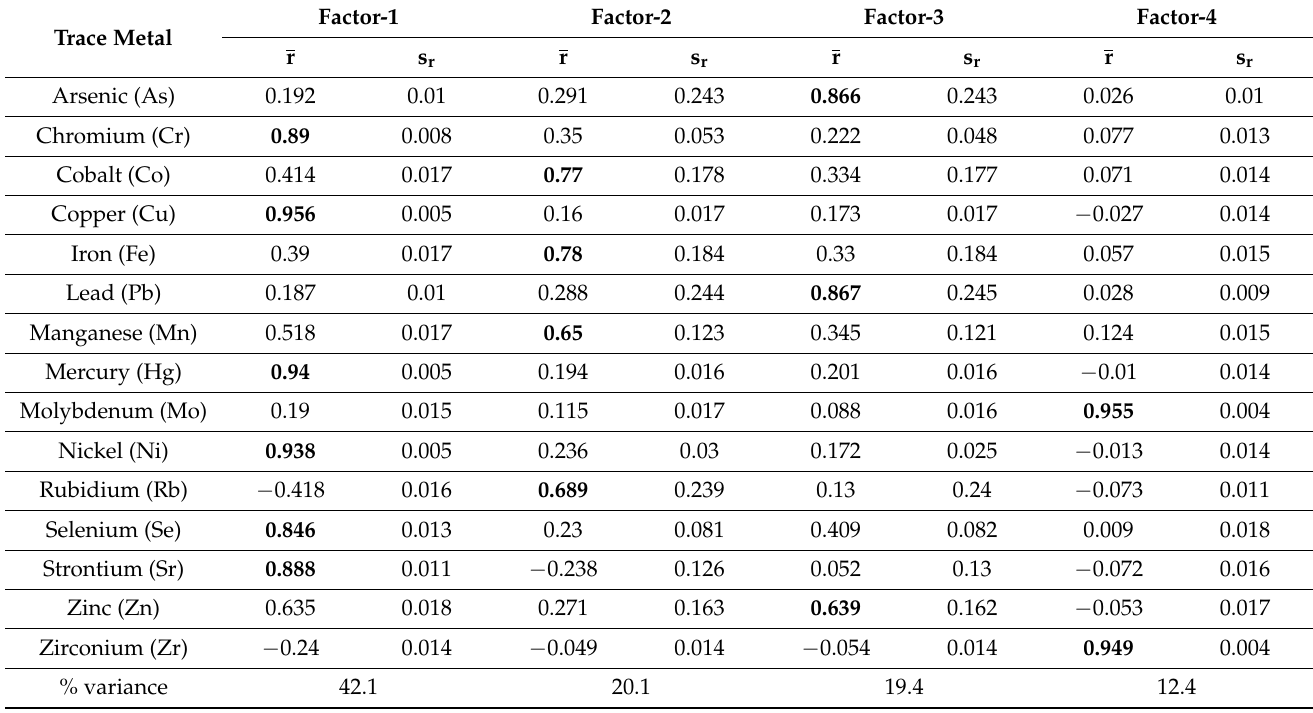
Table 5. Log-normal distribution simulated Syracuse trace metal analytical assay measurement error varimax-rotated factor dimensions: census tract averaged soil sample data (10,000